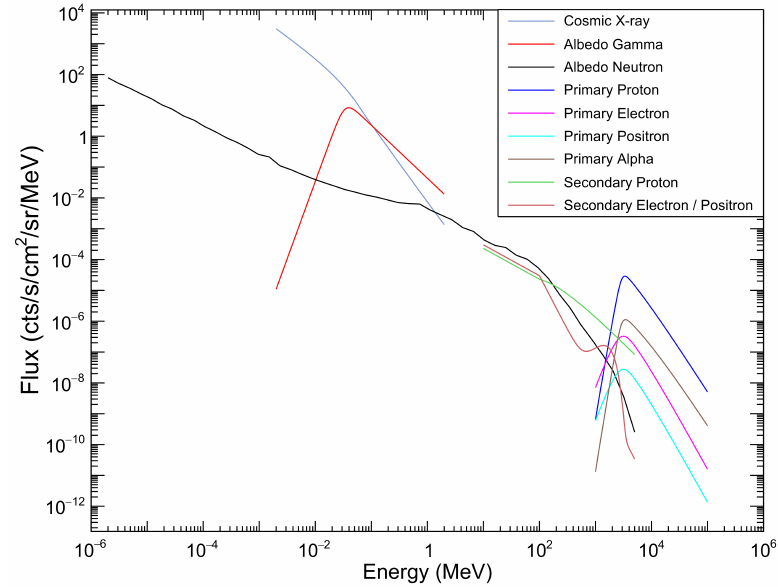
Figure 3. The spectra of the ten background components simulated outside the SAA.